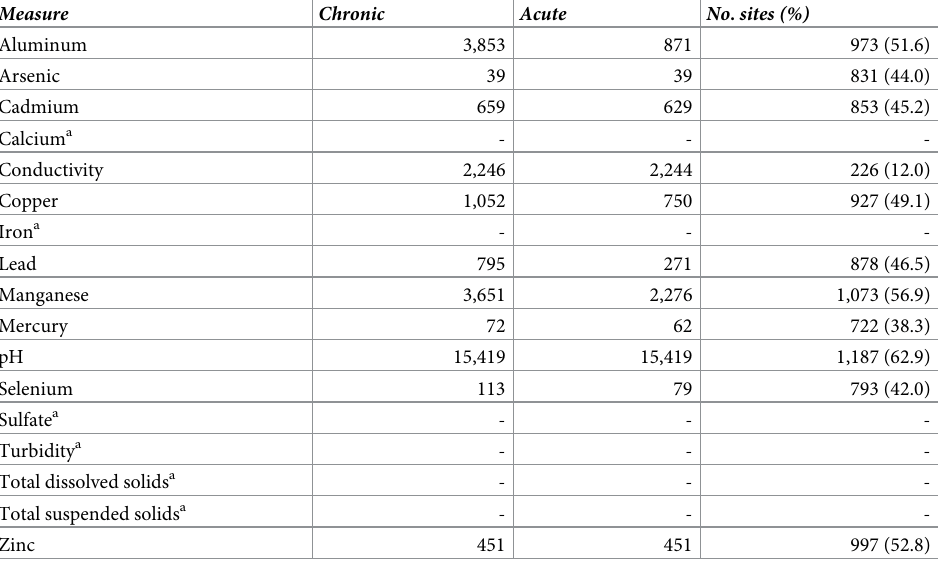
Table 1. Chronic and acute toxicity thresholds were exceeded many times in waterways important to listed aquatic